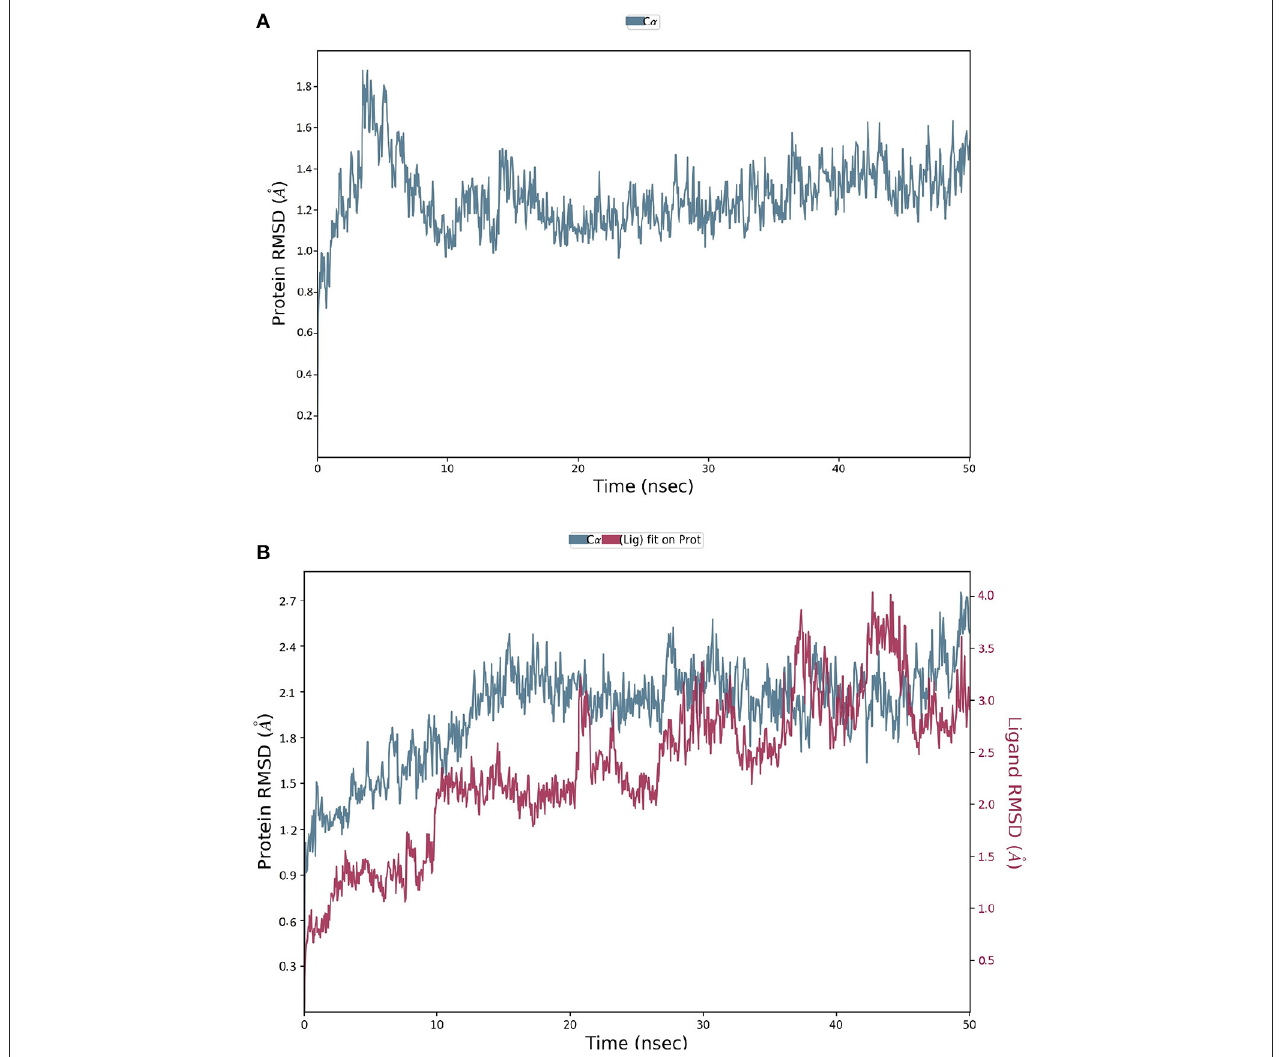
FIGURE 5 | Results of MD of NZO-SARS-CoV-2 S-protein-ACE-2 complex. (A) RMSD of the apo form of SARS-CoV-2 S-protein-ACE-2. (B) RMSD of the NZO-SARS-CoV-2 S-protein-ACE-2 complex. The RMSDs were stable after 20 ns and converged at 2.1